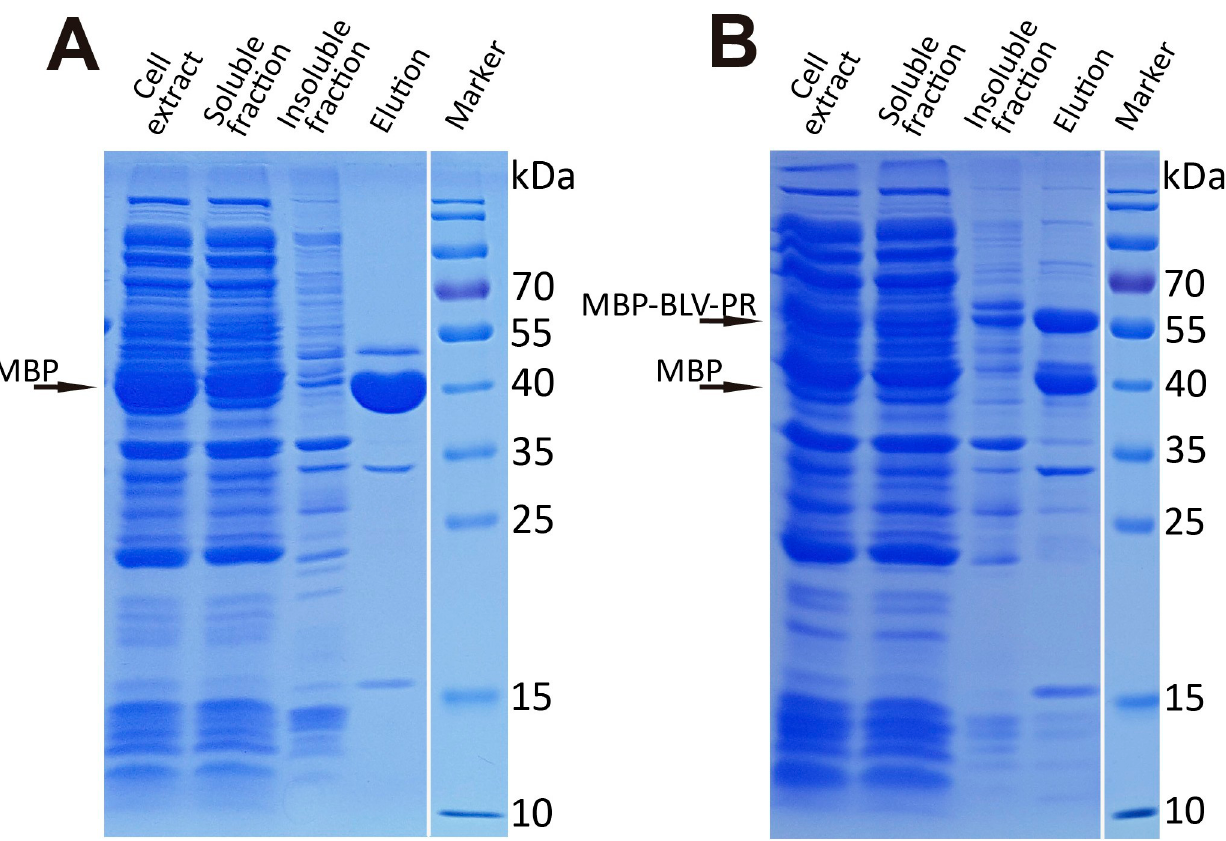
Fig 2. SDS-PAGE analysis of the expression of the PR of BLV constructs in E . coli and the purification step by nickel affinity chromatography. Expression of the construct MBP-pr-BLV-PR (A), and MBP-tev-BLV-PR (B) . The arrows indicate the bands corresponding to MBP and MBP-BLV-PR. The vertical white line indicates the removal of non-relevant